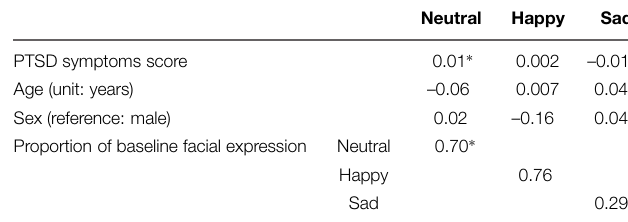
TABLE 3 | Association between Facial Expression and PTSD Symptoms Score a